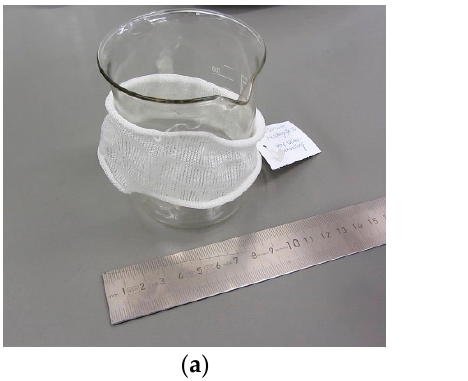
Figure 10. A knitted tube comprised of a shape memory blend yarn in widened state before stimulation ( a ) and tightened state after stimulation ( b ) (Video S1 of Supplementary Materials).